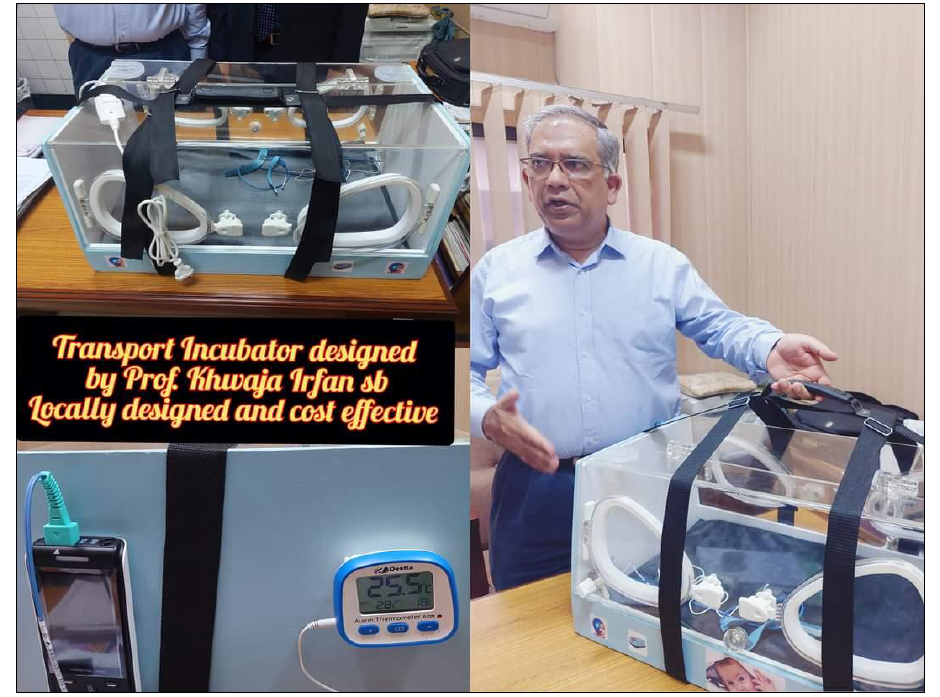
Figure 1: Prof. Irfan Waheed Khawaja introducing a locally made neonatal transport system with in-built temperature monitoring and management system, and pulse